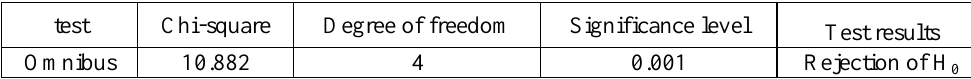
Table 3. Omnibus test